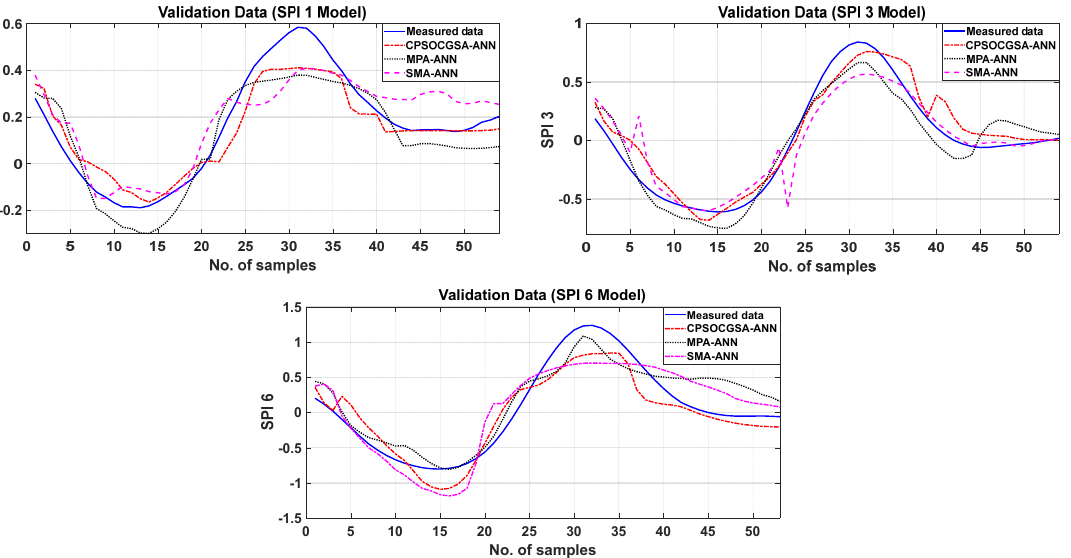
Figure 10. Comparison between measured data (i.e., SPI 1, SPI 3, and SPI 6) and predicted data for CPSOCGSA − ANN, MPA − ANN, and SMA − ANN for the validation stage.